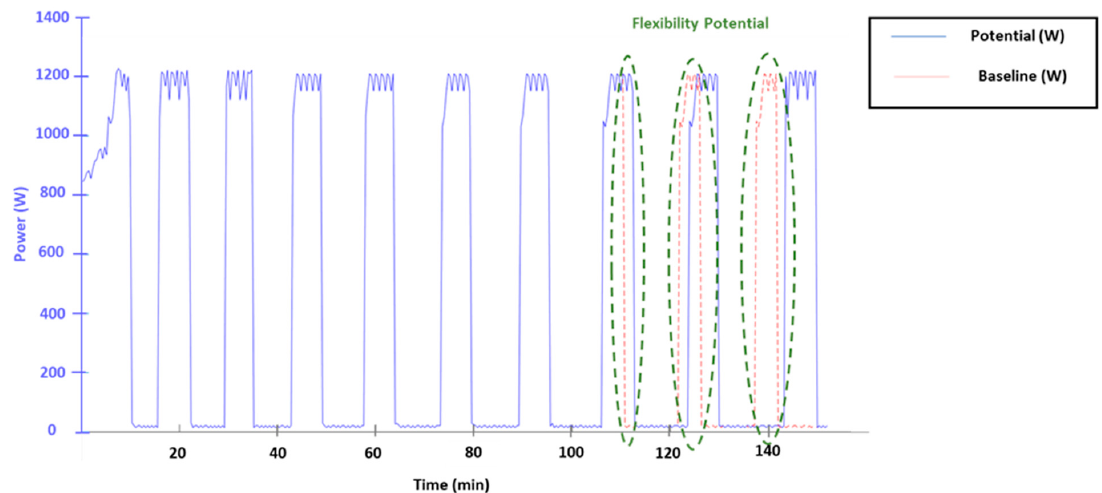
Figure 14. Thermal comfort flexibility.